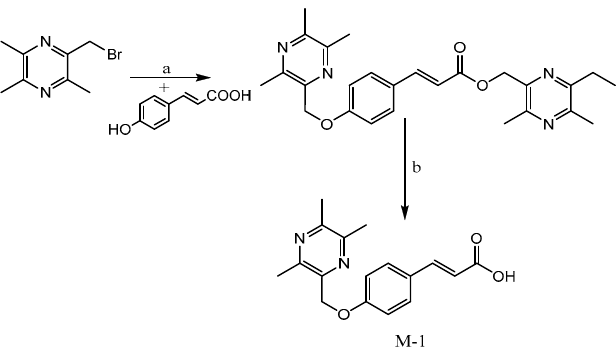
Figure 5. Proposed metabolic pathways of T-CA in rats.